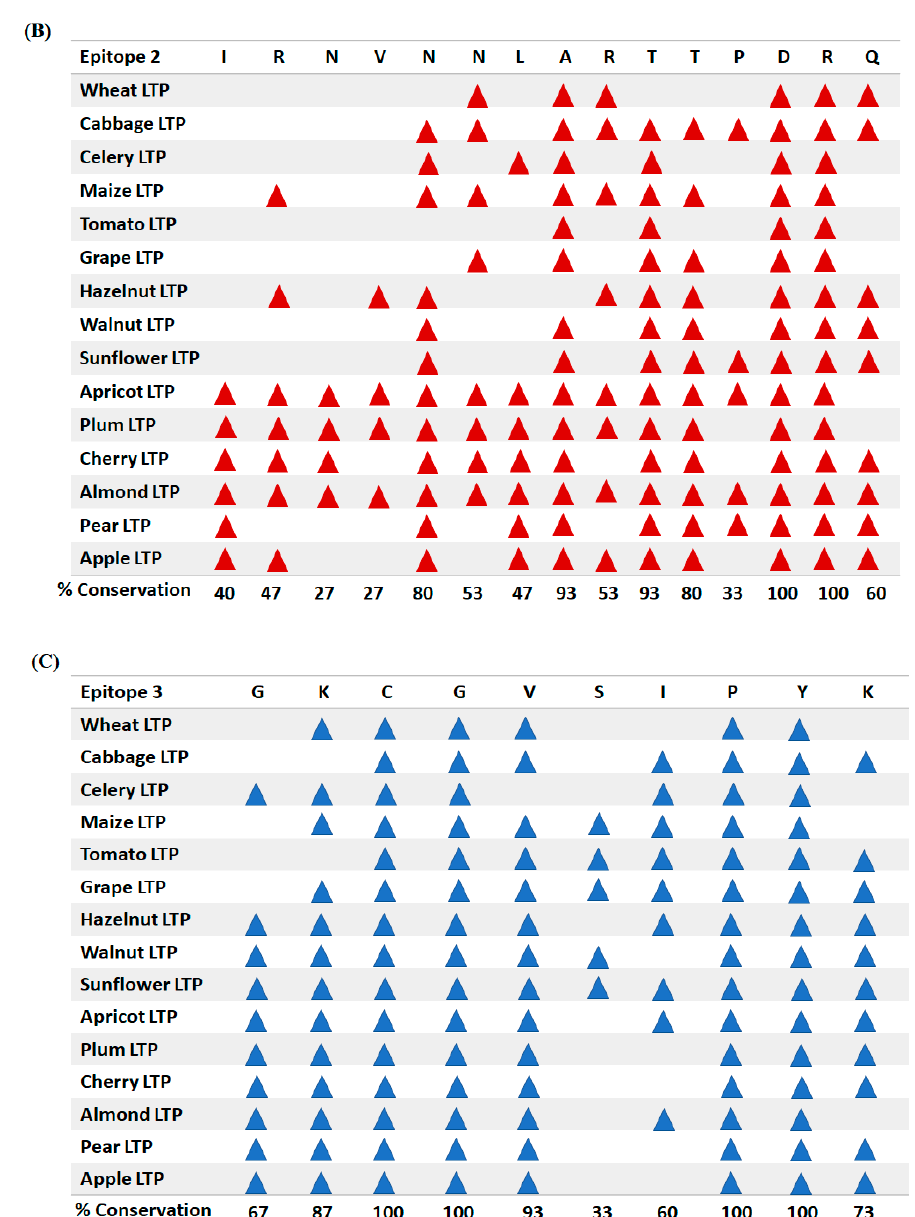
Figure 5. Multiple sequence alignment (MSA) of fifteen allergenic LTPs, in order to identify conservation score for residues corresponding to the experimentally validated B-cell epitopes of peach LTP. ( A ): Epitope 1st, ( B ): Epitope 2nd, and ( C ): Epitope 3rd, respectively.